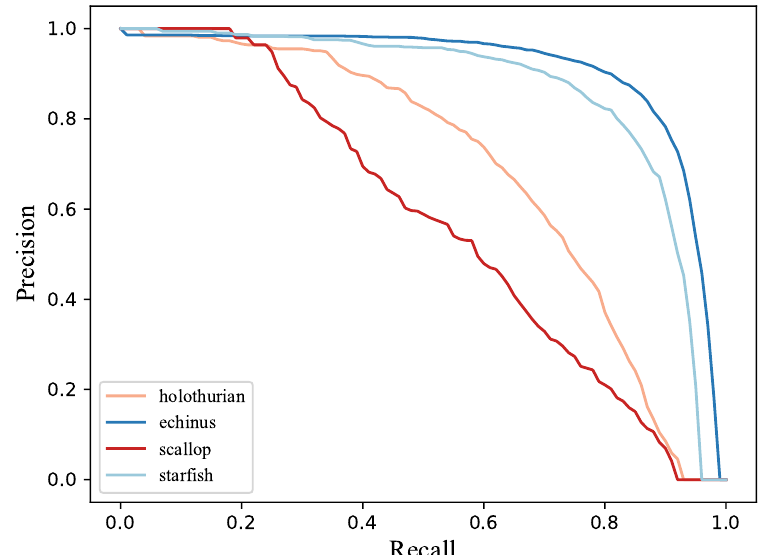
Figure 9. Precision–recall curves for each category in URPC 2018. There are four categories in the dataset. The area under the curve indicates the performance of that model in the specific category. The larger the area, the better the model